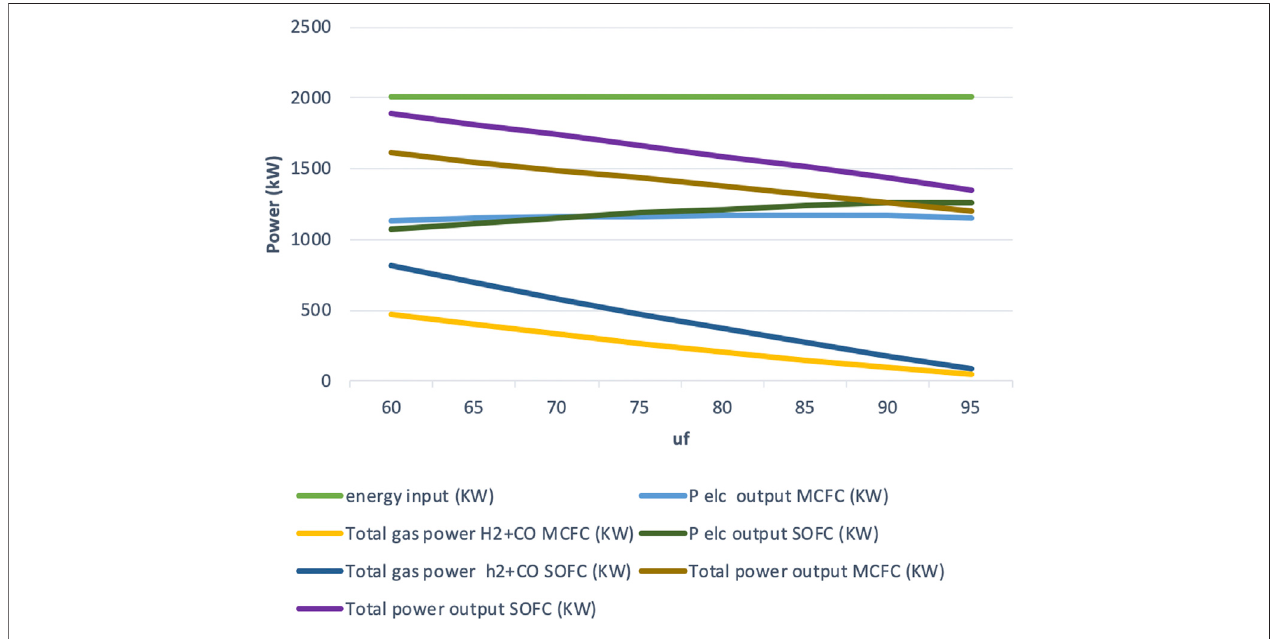
FIGURE 2 | Power output vs. fuel utilization for high-ef fi ciency mode.